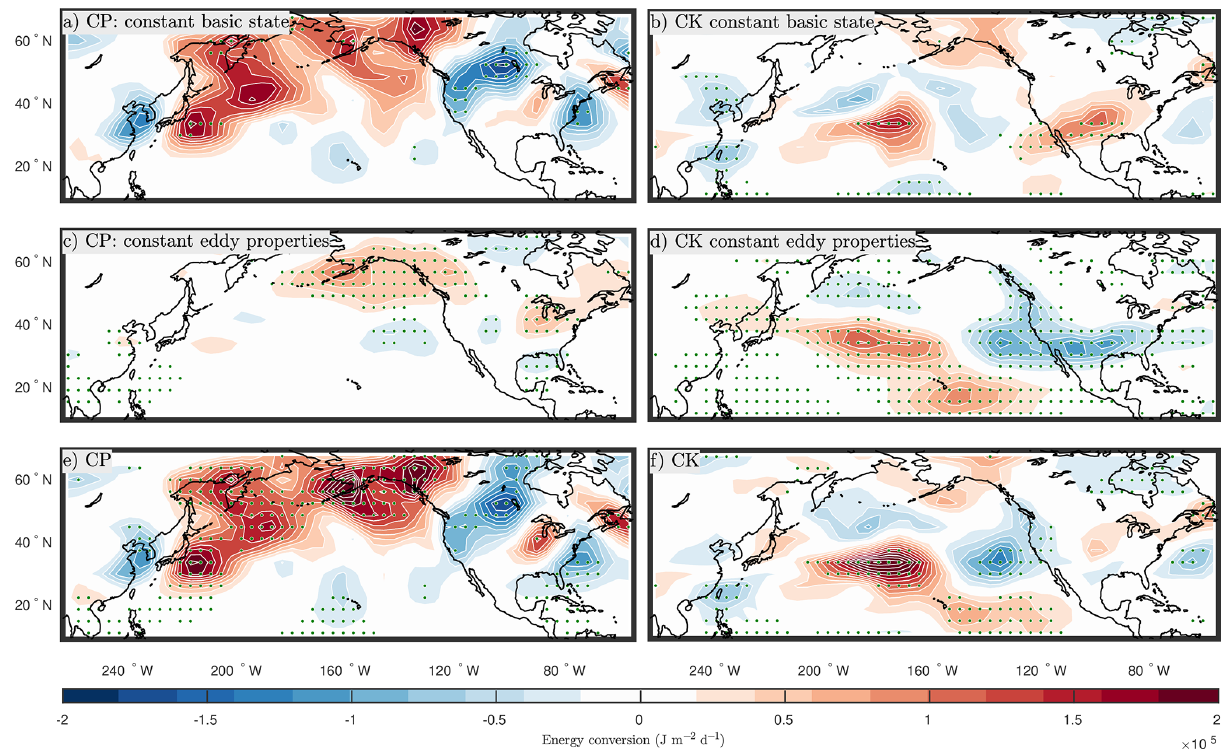
Figure 5. Baroclinic energy conversion (CP; a, c, e ) and barotropic energy conversion (CK; b, d, f ) composite differences between the positive (SVD1 SST > 0 . 75) and negative (SVD1 SST < − 0 . 75) phases of SVD1 (representing La Niña) are calculated by keeping either the background flow properties (a, b) or eddy properties (c, d) constant every year. For reference, the composite difference when both eddy properties and the basic state can change from year to year is shown in panels (e) and (f) . Composite differences that are significant at the α FDR = 0 . 1 significance level are